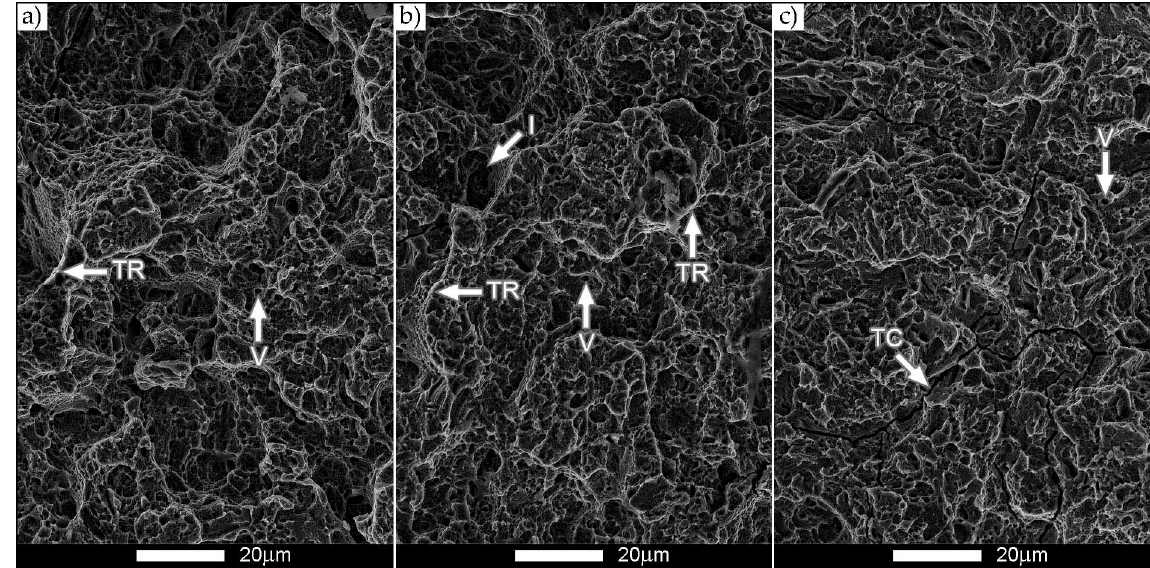
Figure 11. Images of the Hardox Extreme steel fracture surface in delivery state shown in Figure 9: longitudinal orientation (+20 °C). ( a ) The area marked with the A1 frame. ( b ) The area marked with the B1 frame. ( c ) The area marked with the C1 frame. TR—tear ridges, V—microvoids, I—inclusions, voids left after debonded inclusions, TC—transversal cracks. SEM, non-etched state.